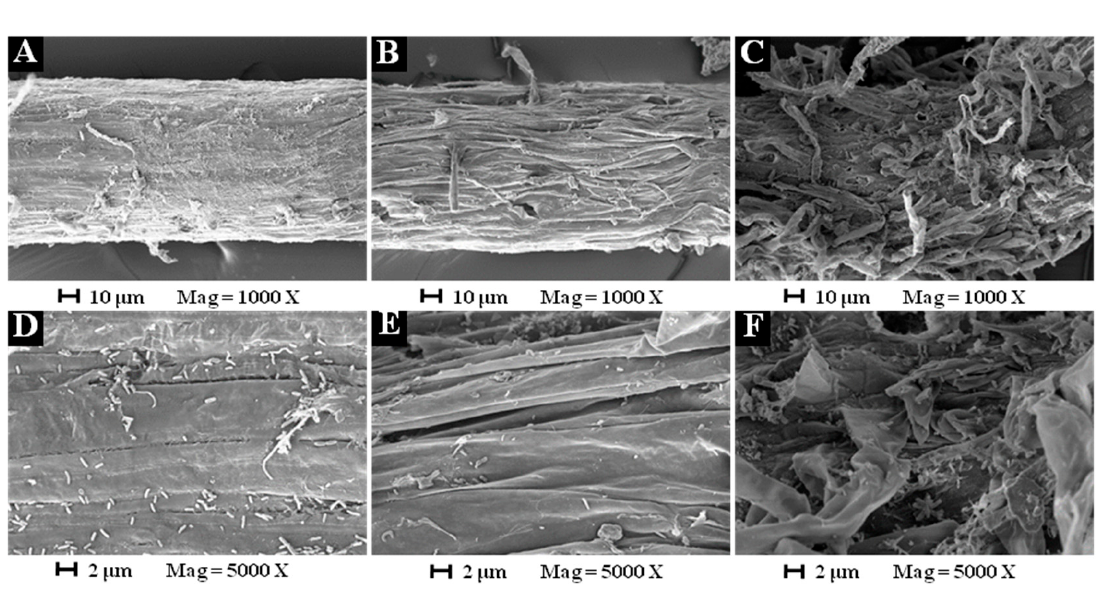
Figure 5. Scanning Electron Microscope (SEM) observation on the root tip mature area of Bidens pilosa . ( A , D ) Untreated control (magnification, × 1000 and × 5000); ( B , E ) treated with 500 mg L − 1 dirhamnolipid (magnification, × 1000 and × 5000); ( C , F ) treated with 1000 mg L − 1 dirhamnolipid (magnification, × 1000 and × 5000).